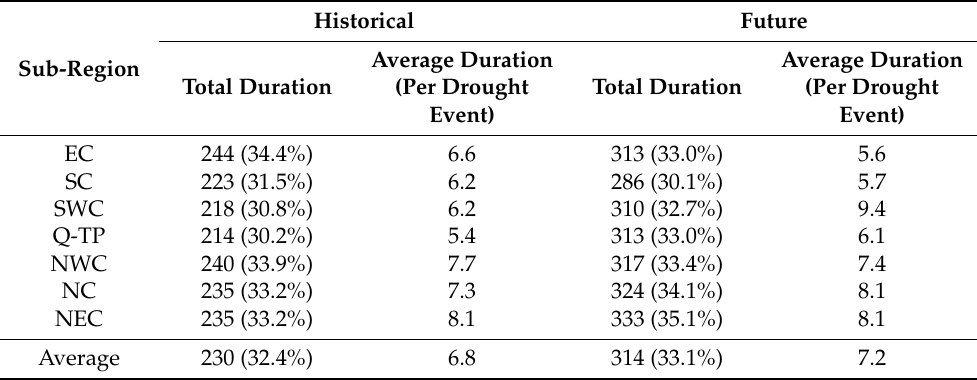
Table 6. Drought duration in each sub-region during the historical period (1961–2020) and the future period